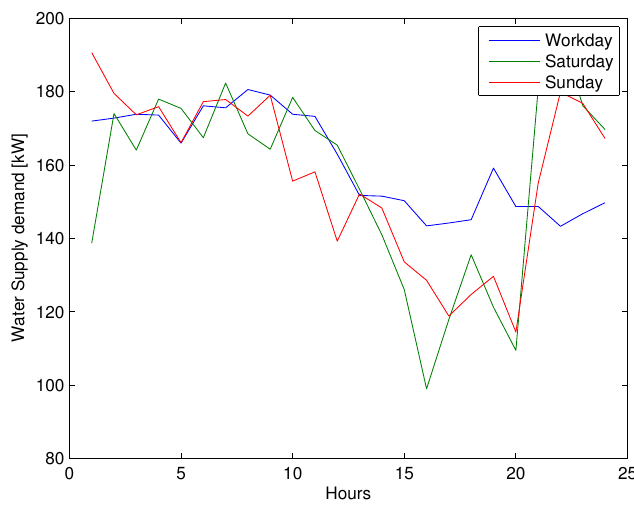
Figure 7. Water Supply curves for three representative days of the week.